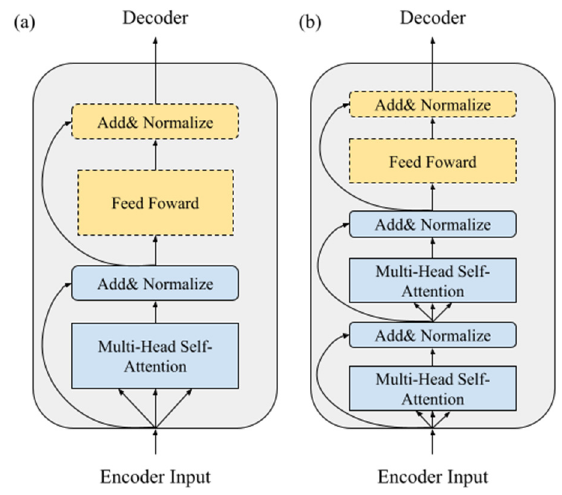
Figure 4. ( a ) Encoder layer of the transformer; ( b ) modified encoder layer of the X-Transformer.